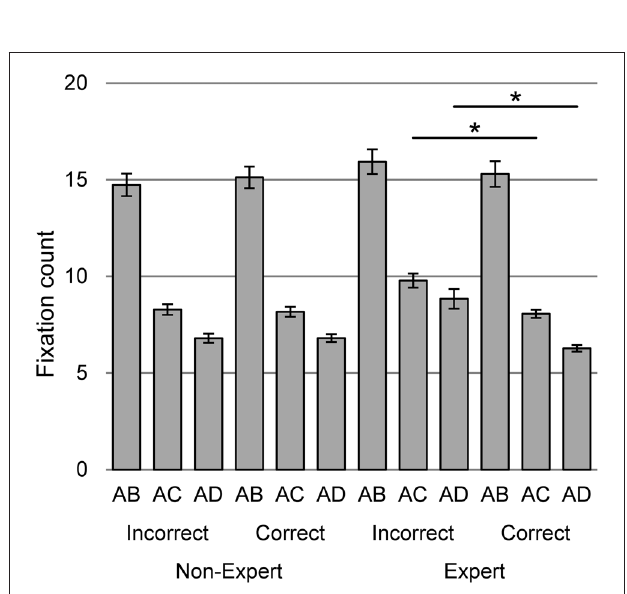
FIGURE 5 | The interaction of accuracy of paintings evaluation, expertise and difference between paintings in pair on the number of fixation during evaluation of two versions of the same painting. Vertical bars denote ± standard errors, ∗ means a significant